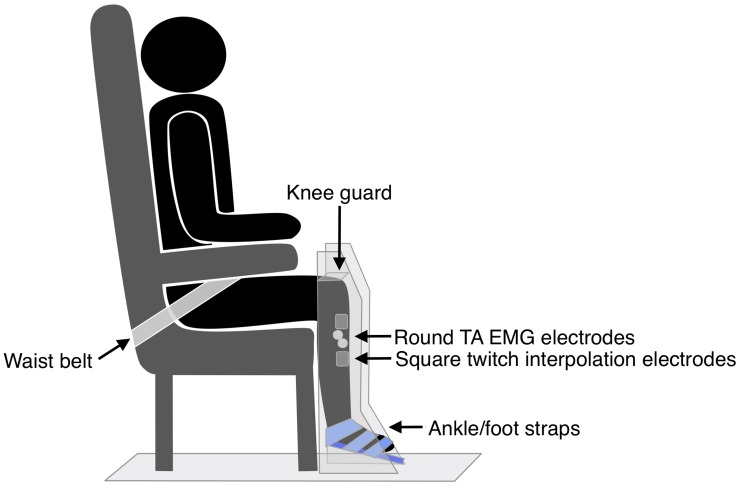
Set up for strength and fatigue outcome measures.